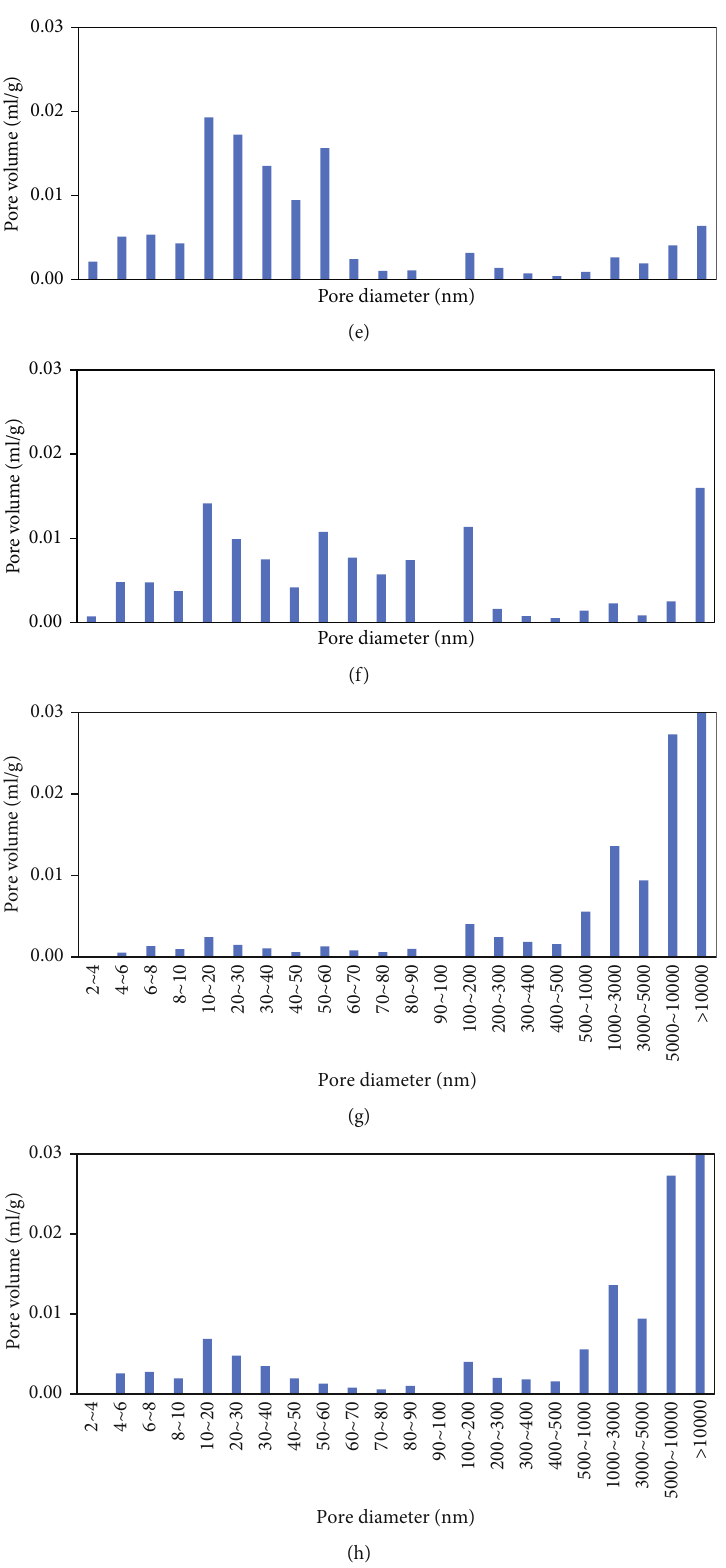
Figure 10: The pore volume distribution of mudstone in the Qigequan Formation. (a) H-1: pure mudstone; (b) H-2: pure mudstone; (c) H-3: pure mudstone; (d) H-4: silty mudstone; (e) H-5: silty mudstone; (f) H-6: silty mudstone; (g) H-7: sandy mudstone; (h) H-8: sandy